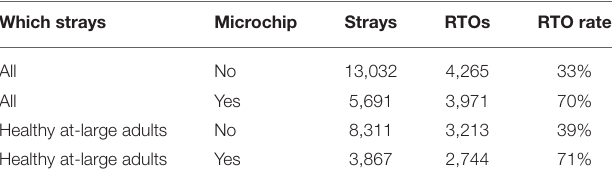
TABLE 3 | RTO rates for all strays and healthy, at-large, adult strays with and without microchips. Which strays Microchip Strays RTOs RTO rate